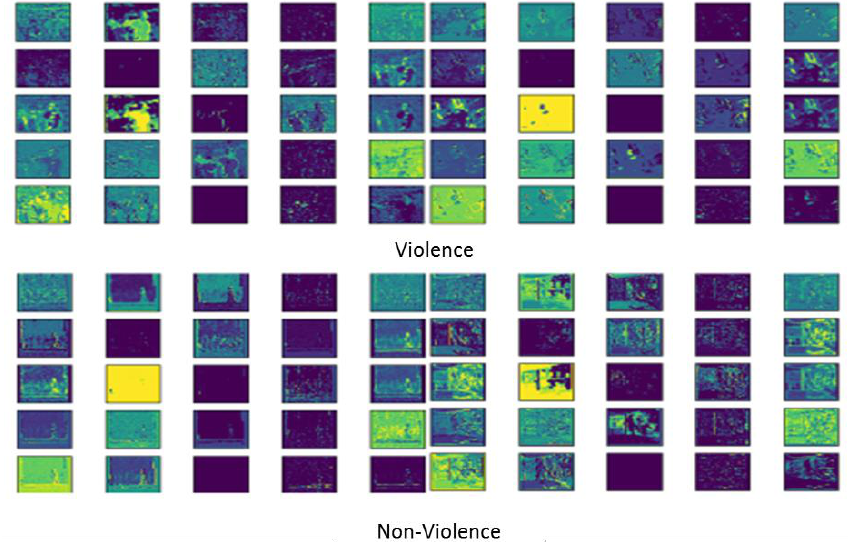
Figure 4. Feature maps of violence and non-violence scenes.